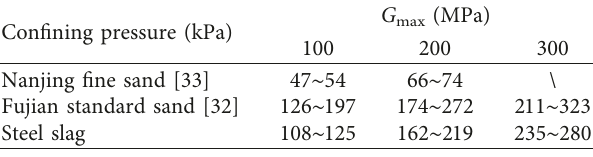
Table 6: Comparisons of G sand.